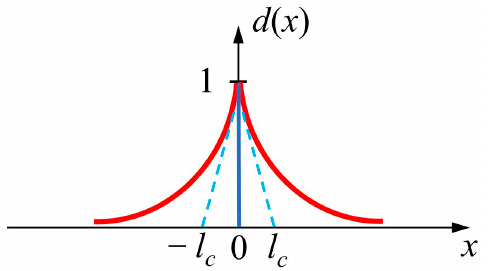
Figure 1. Modeling the sharp crack at x = 0 and the diffusion crack represented by Equation (1).